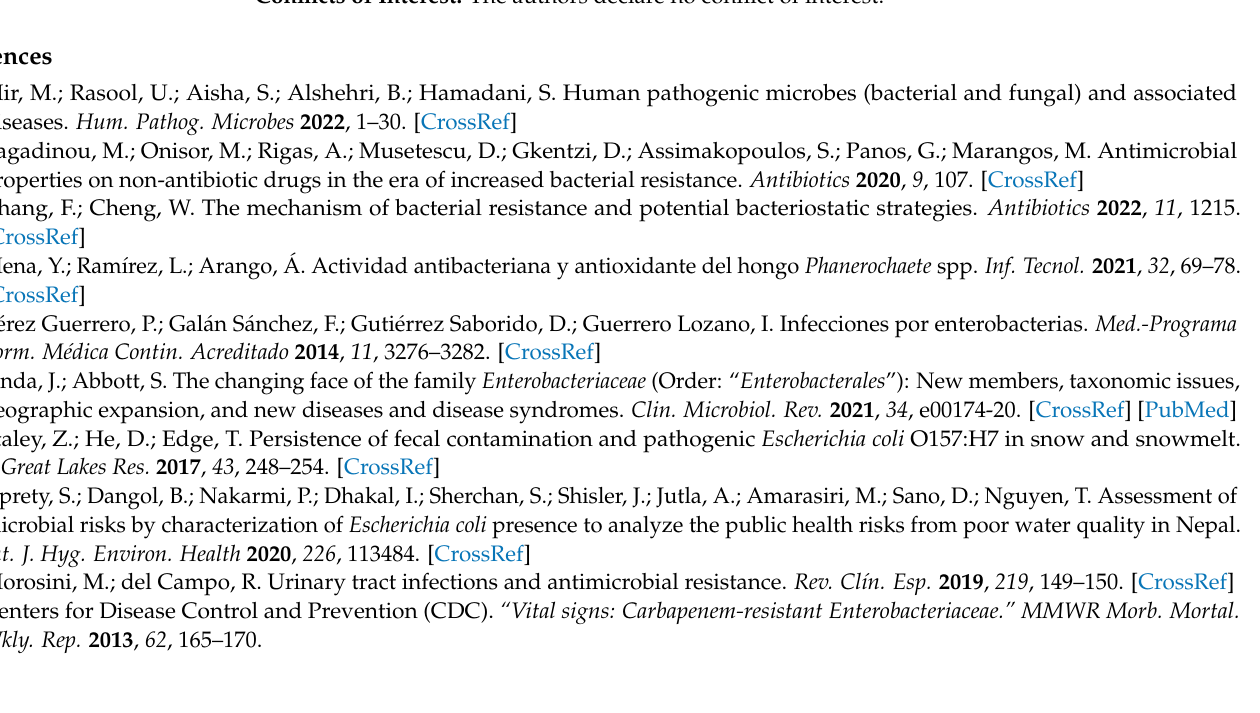
Figure S2: Maximum Likelihood phylogenetic tree for the ITS1-5.8-ITS2 region for sequence positioning corresponding to Gloeocystidiellum lojanense sp. nov. Bar = number of expected substitutions per position. * Sequences generated in this study; Figure S3: Maximum likelihood phylogenetic tree for the LSU region for sequence positioning corresponding to Gloeocystidiellum lojanense sp. nov. Bar = number of expected substitutions per position. * Sequences generated in this